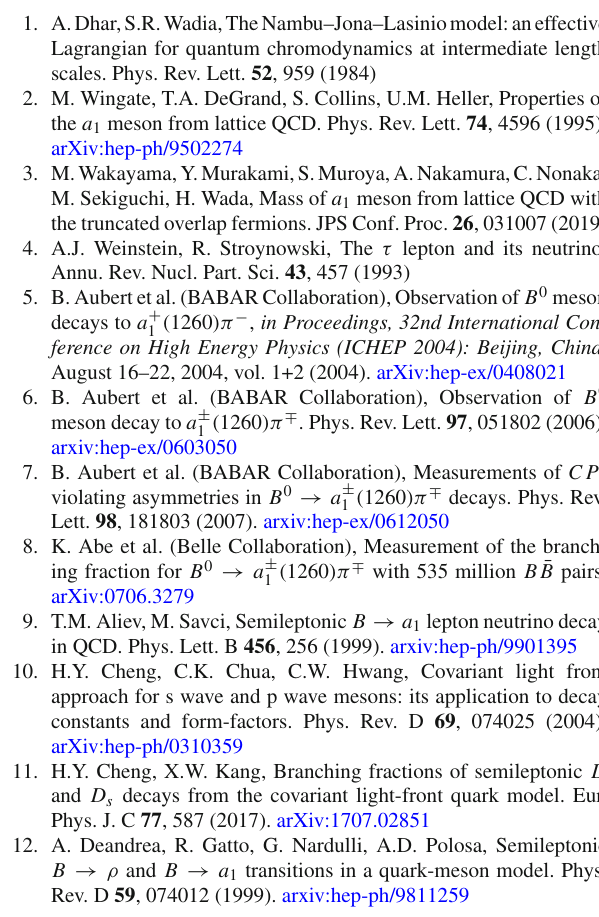
decay width of semileptonic decay D → a 1 ( 1260 )(cid:4) + ν (cid:4) with (cid:4) = ( e , μ) have been given in Fig. 4, and the branching − ( 0 ) (cid:4) + ν (cid:4) are given in Table 6. The fractions for D 0 ( + ) → a 1 branching fractions are of order 10 − 5 , which is close to the present experimental upper limit. It is hoped that the decays D → a 1 ( 1260 )(cid:4) + ν (cid:4) can be observed in near future, which inversely could provide a (potential) helpful test for QCD sum rules